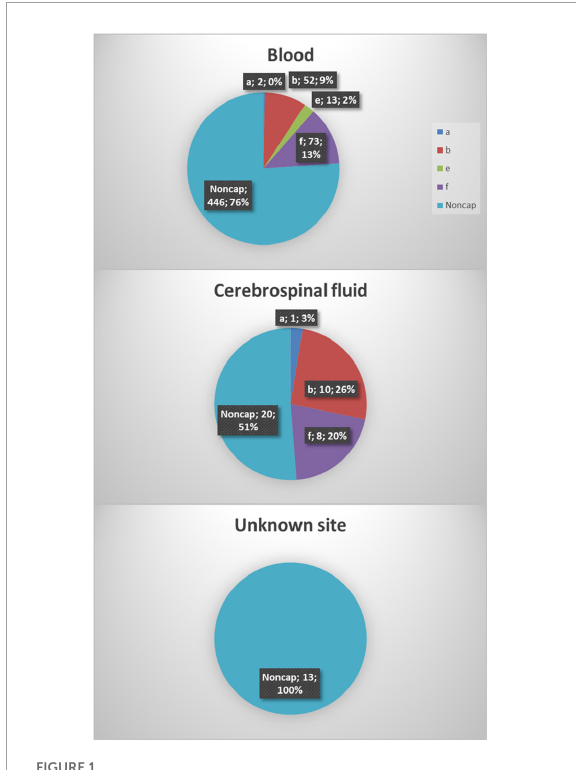
FIGURE1 A total of six hundred thirty-eight Haemophilus influenzae isolates were included in the study. The majority of the isolates were from blood samples (91.8%, 586), 6.1% (39) were from cerebrospinal fluid, and information on the origin of 2% (13) of isolates was not